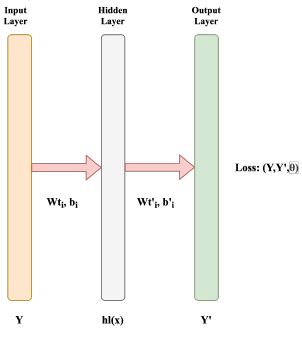
Figure 2. An autoencoder’s